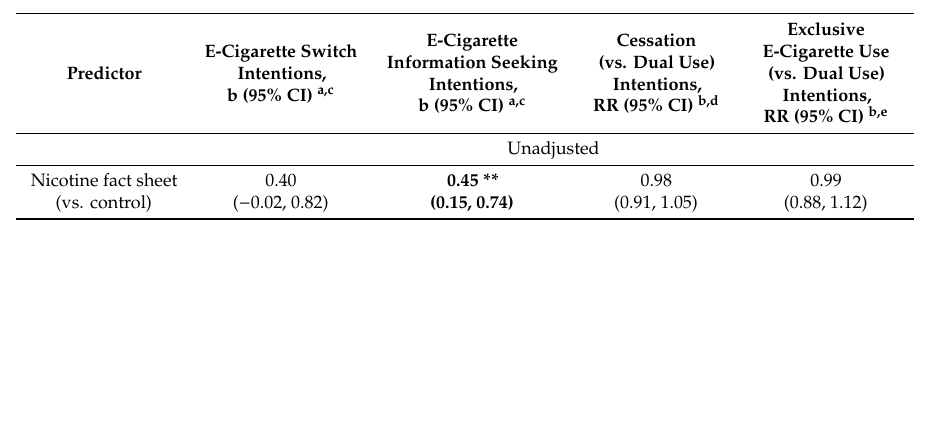
Table 5. E ff ects of a nicotine fact sheet on behavioral